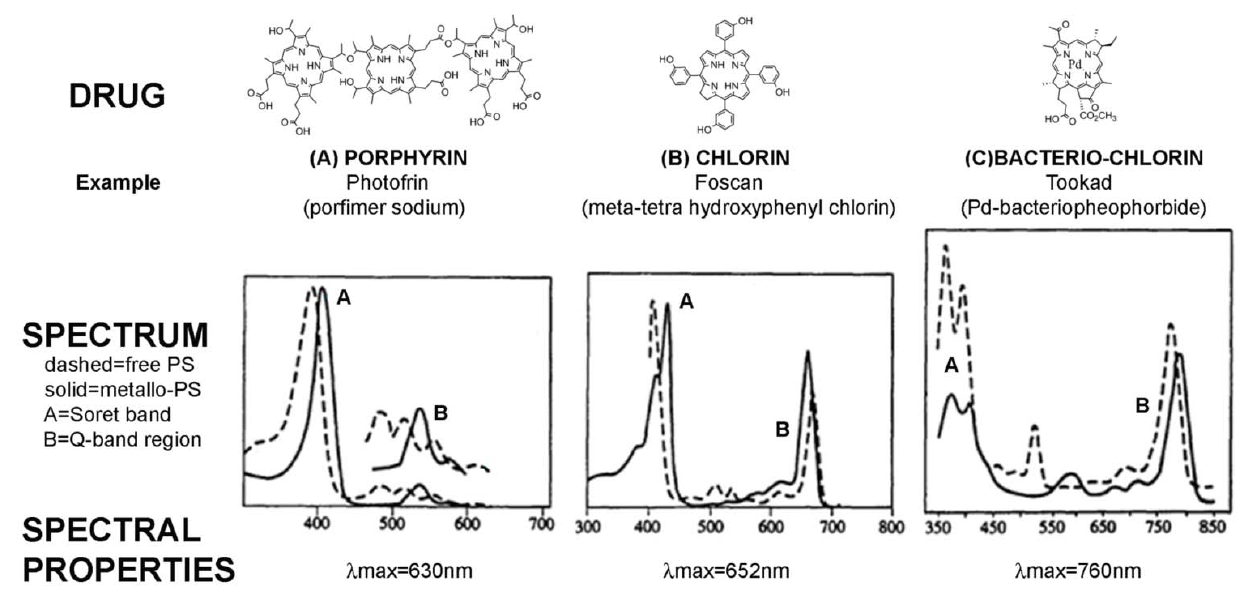
Figure 3. Structures and spectral properties of example PS-drugs. UV/Vis absorption spectra and structures of a basic porphyrin, chlorin and bacteriochlorin. Peaks labelled A shows the Soret band, a characteristic strong absorption peak around 400 nm. A set of 4 bands in the region of 500–800 nm are called the Q bands and are labelled B. The reduction of a double bond in the central tetrapyrolle ring as the transition from a porphyrin to a chlorin and to the bacteriochlorin occurs causes a red shift in absorption in the Q band region [18]. Taken and modified from